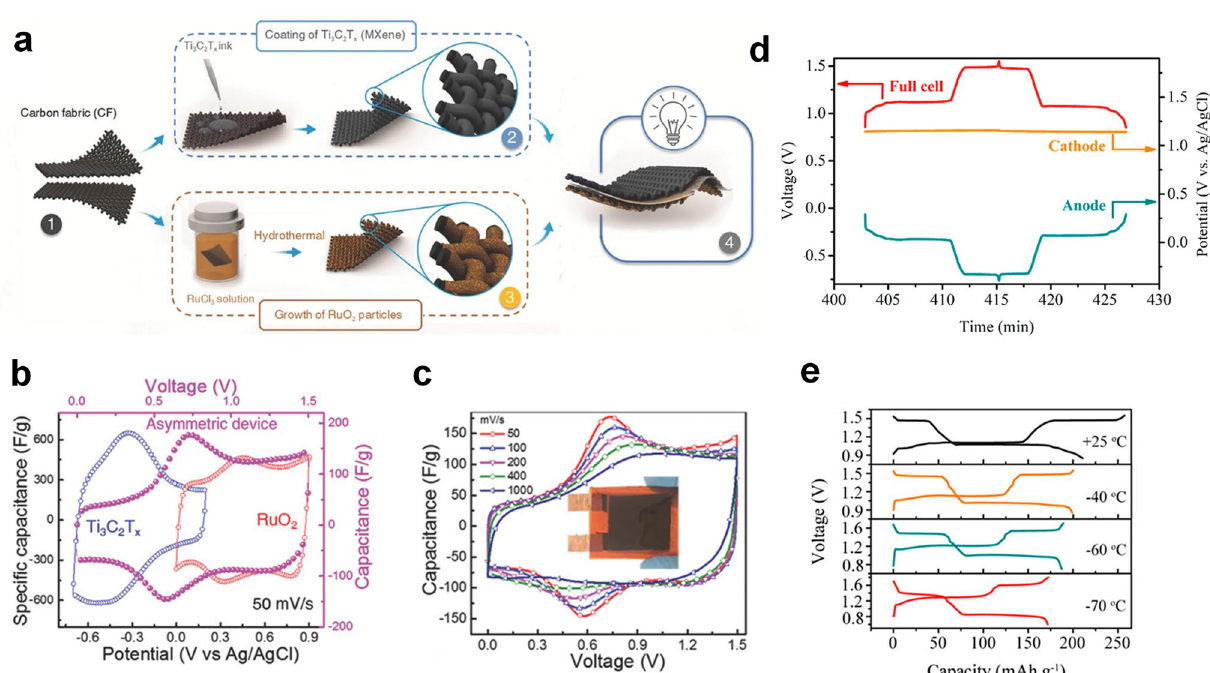
Fig. 10 a The fabrication process of RuO 2 //Ti 3 C 2 T x asymmetric proton pseudocapacitor. b In situ tracked variation of the potential in RuO 2 /CF electrode, Ti 3 C 2 T x /CF electrode, and RuO 2 //Ti 3 C 2 T x asymmetric device. c Capacitance of RuO 2 //Ti 3 C 2 T x asymmetric device at different scan rates [103]. Copyright 2018, Wiley–VCH. d The comparison of galvanostatic charge–discharge curves of MnO 2 @GF//MoO 3 full cell, MnO 2 @ GF cathode, and MoO 3 anode at 1 mA cm −2 . e Galvanostatic charge–discharge curves of MnO 2 @GF//MoO 3 full cell at different temperatures [40]. Copyright 2020, American Chemical